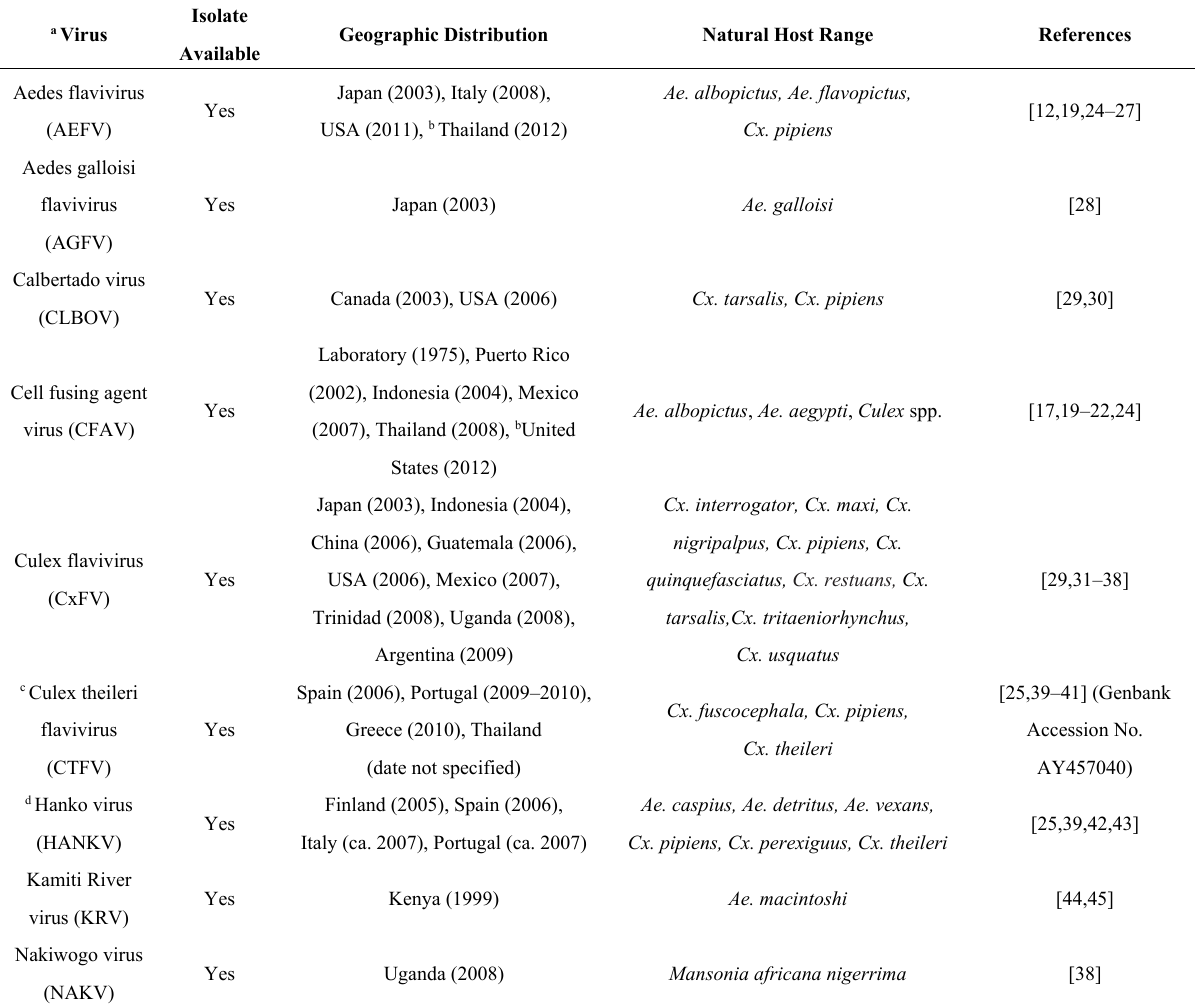
Table 1. Geographic distribution and natural host range of classical insect-specific